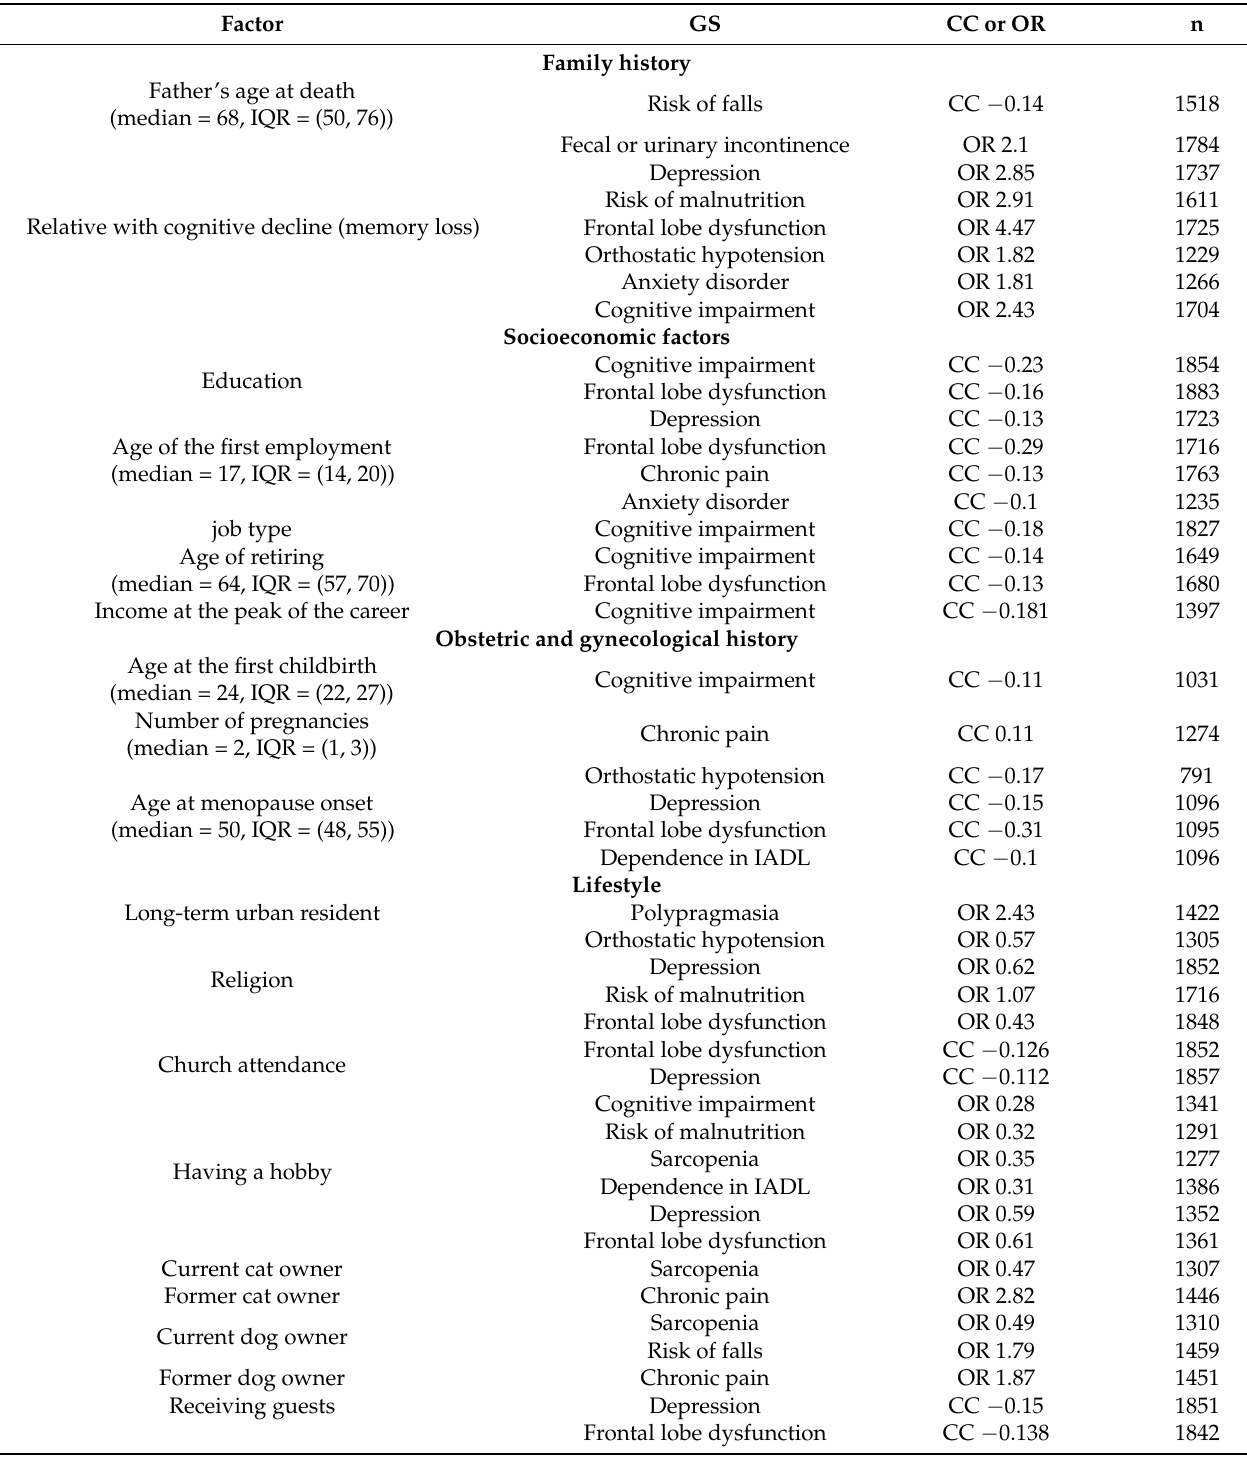
Table 2. The statistically significant associations between the GSs and evaluated factors ( p - value <